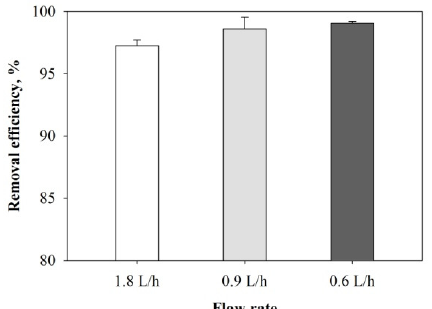
Figure 6. Removal efficiencies of As(III) in FeOOH coated sand filter at different flow rates.